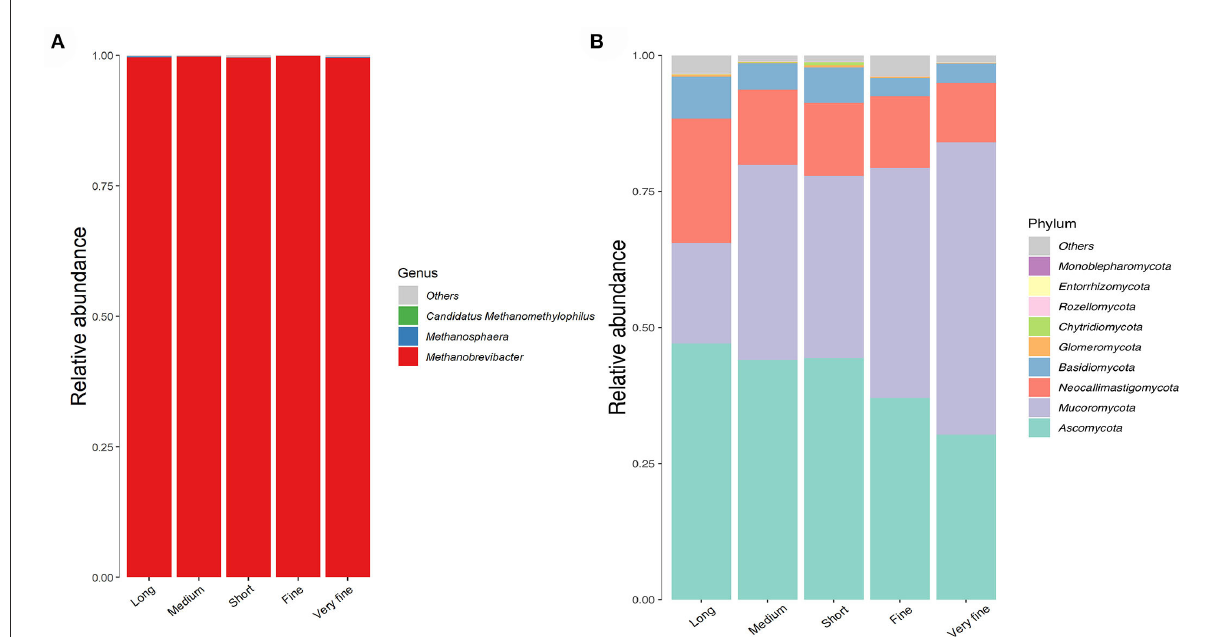
FIGURE3 The histogram of the relative abundance of archaea at genus level (A) and fungi at phylum level (B) . Long: 32.97% peNDF > 1.18 treatment; Medium: 29.93% peNDF > 1.18 treatment; Short: 28.14% peNDF > 1.18 treatment; Fine: 26.48% peNDF > 1.18 treatment; Very fine: 24.75% peNDF > 1.18 treatment.